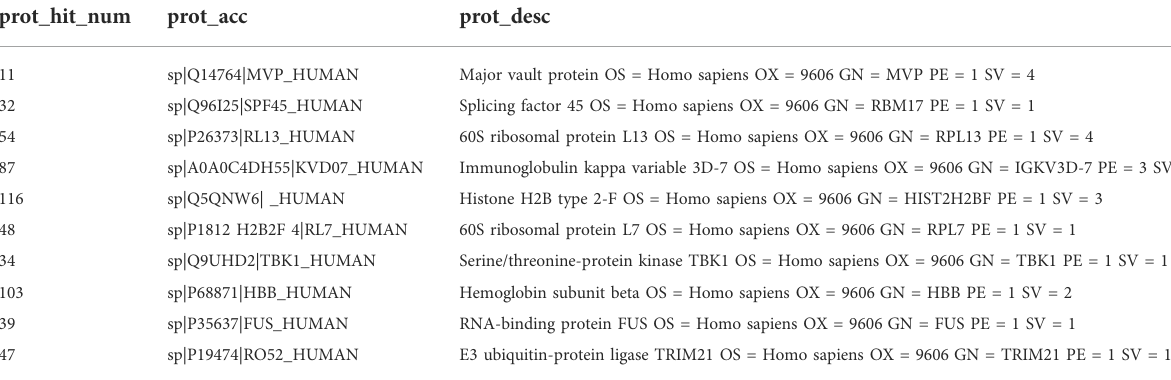
TABLE 2 Potential proteins that bind to circLIFR as predicted by pulldown